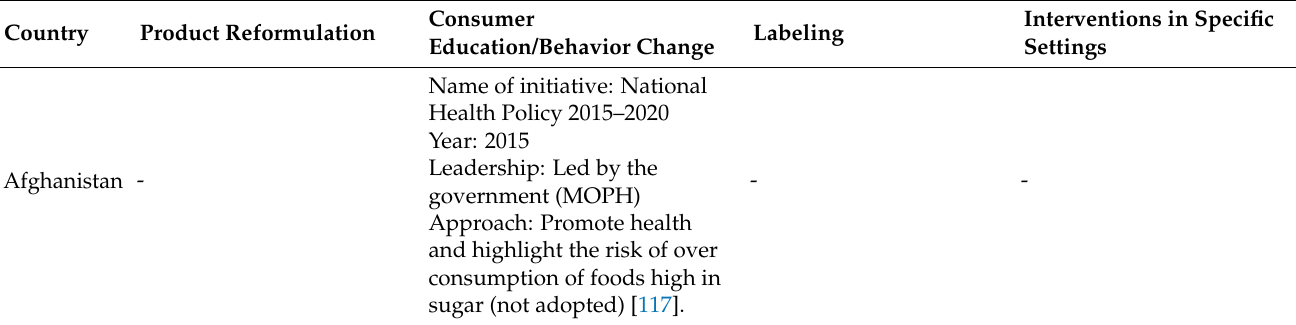
Table 2. Sugar reduction implementation strategies in countries of the EMR: product reformulation, consumer education, labeling and interventions in specific settings. Consumer Interventions in Specific Labeling Education/Behavior Change